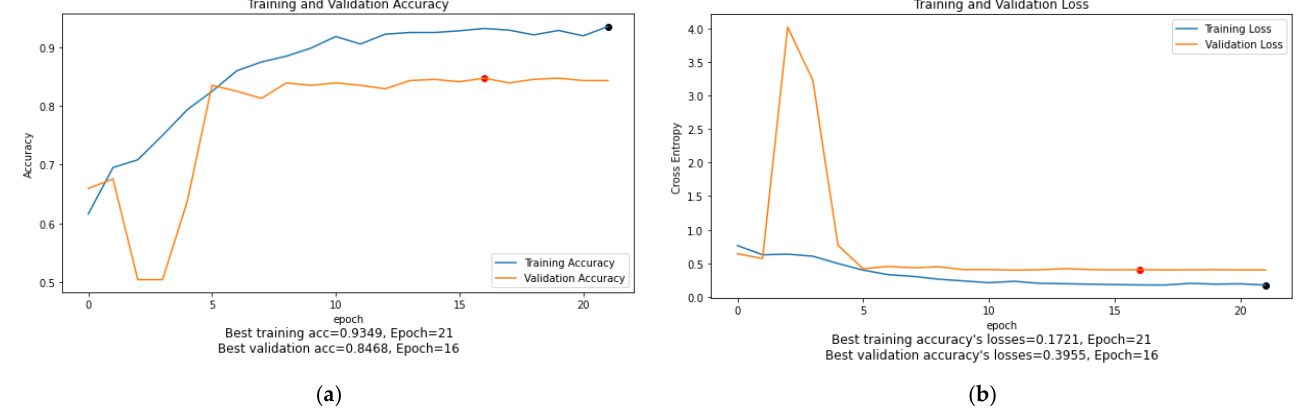
Figure 15. ( a ) Accuracy and ( b ) loss plots throughout the training process of the ViT-B32 model using the GRAY+GRAY_HE+GRAY_CLAHE image representation.